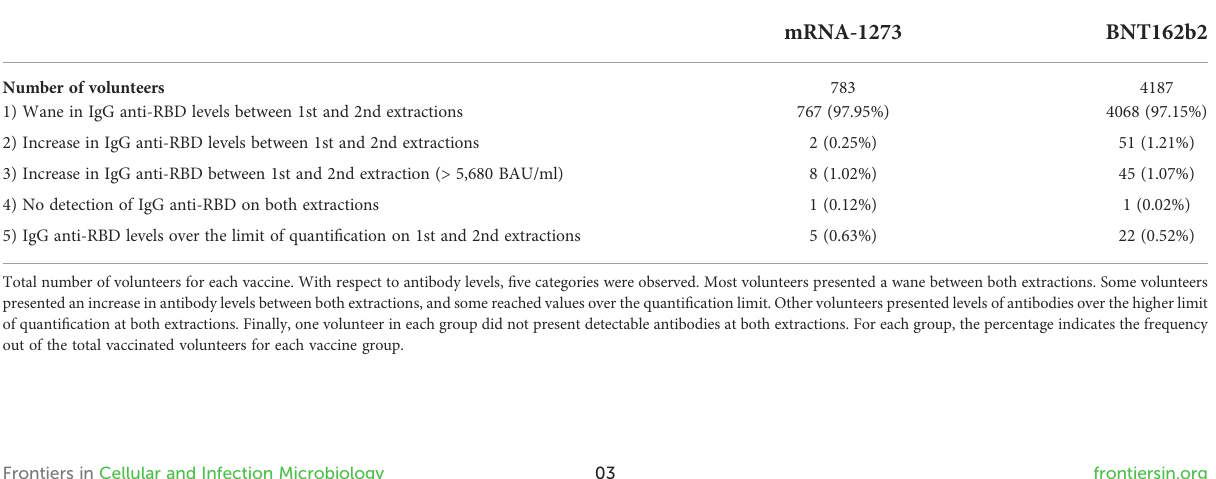
TABLE 1 Total volunteers vaccinated with mRNA-1273 and BNT126b2 vaccines and